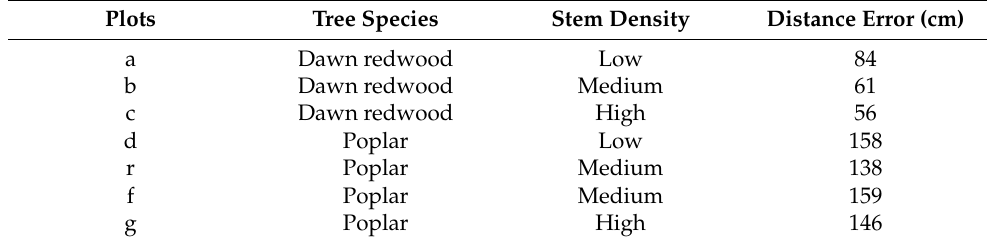
Table 5. The distance error of the coarse co-registration of seven plots. Plots Tree Species Stem Density Distance Error (cm) Dawn